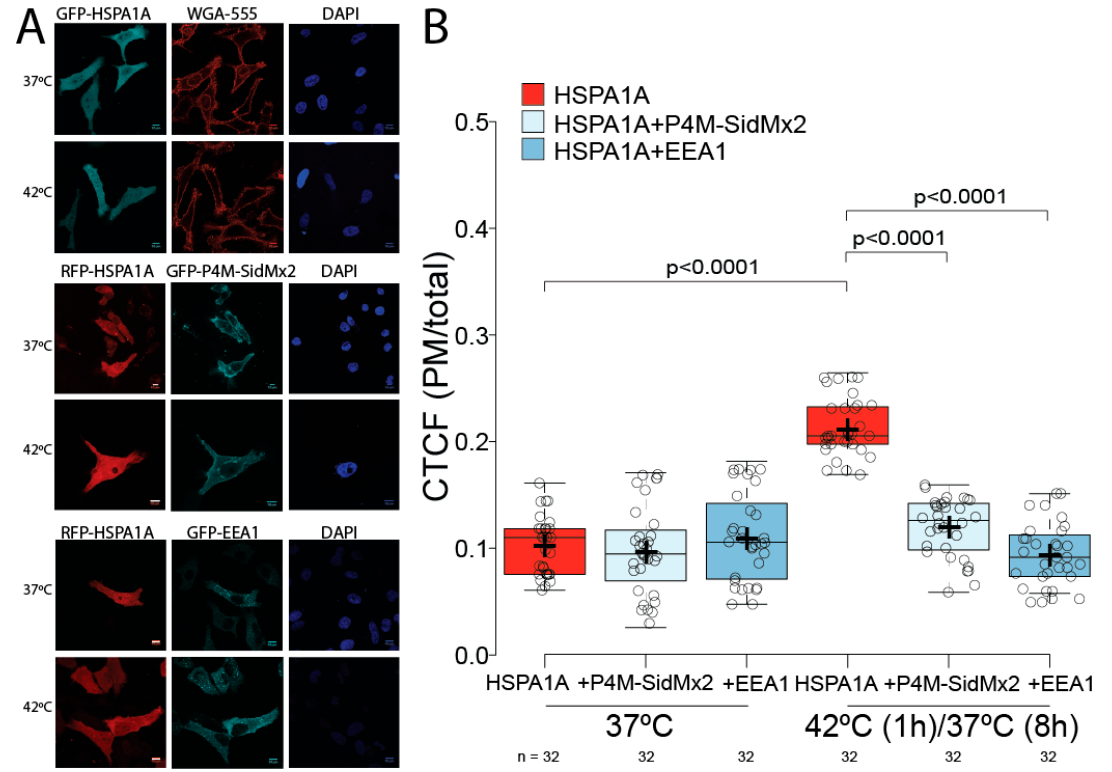
Figure 2. HSPA1A’s PM localization significantly decreases when PI(4)P and PI(3)P are masked by the biosensors P4M-SidMx2 and EEA1. ( A ) Representative images of HeLa cells expressing GFP-HSPA1A stained with WGA-FA555 PM stain and DAPI nucleus stain (top panels). Representative images of the co-expression of RFP-HSPA1A with GFP-P4M-SidMx2 (middle panels) and RFP-HSPA1A with GFP-EEA1 (bottom panels). The localization of HSPA1A was documented for all transfections at either control conditions (37 °C; top row of each panel) or heat-shocked conditions (1h at 42 °C followed by 8 h at 37 °C; bottom row of each panel). Scale bar = 10 μ m. ( B ) Quantification of the corrected total cell fluorescence (CTCF) as a ratio between the total HSPA1A fluorescence of the PM and the rest of the cell at control conditions and after heat shock in the presence or absence of lipid biosensors. The experiment was repeated three times, and the total number of cells (shown as open circles) per condition are shown at the bottom of the graph. The center lines show the medians; box limits indicate the 25th and 75th percentiles as determined by R software; whiskers extend 1.5 times the interquartile range from the 25th and 75th percentiles; crosses represent sample means.